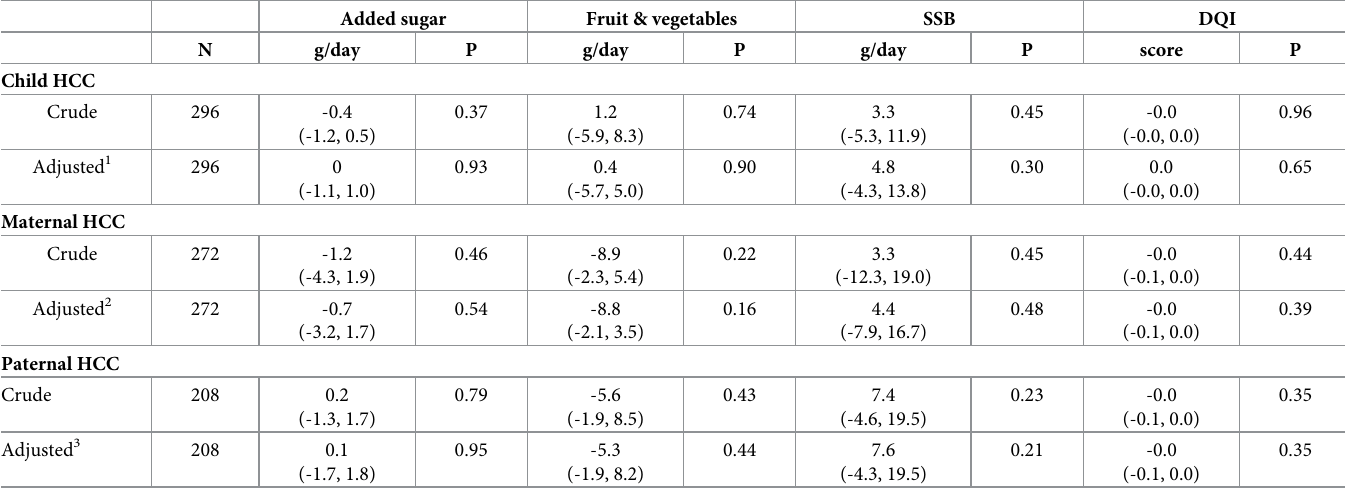
Table 3. Association between child and parental hair cortisol concentration (units of 100 pg/mg) and added sugar, selected food groups and diet quality among chil- dren in the Healthy Start study. Added sugar Fruit & vegetables